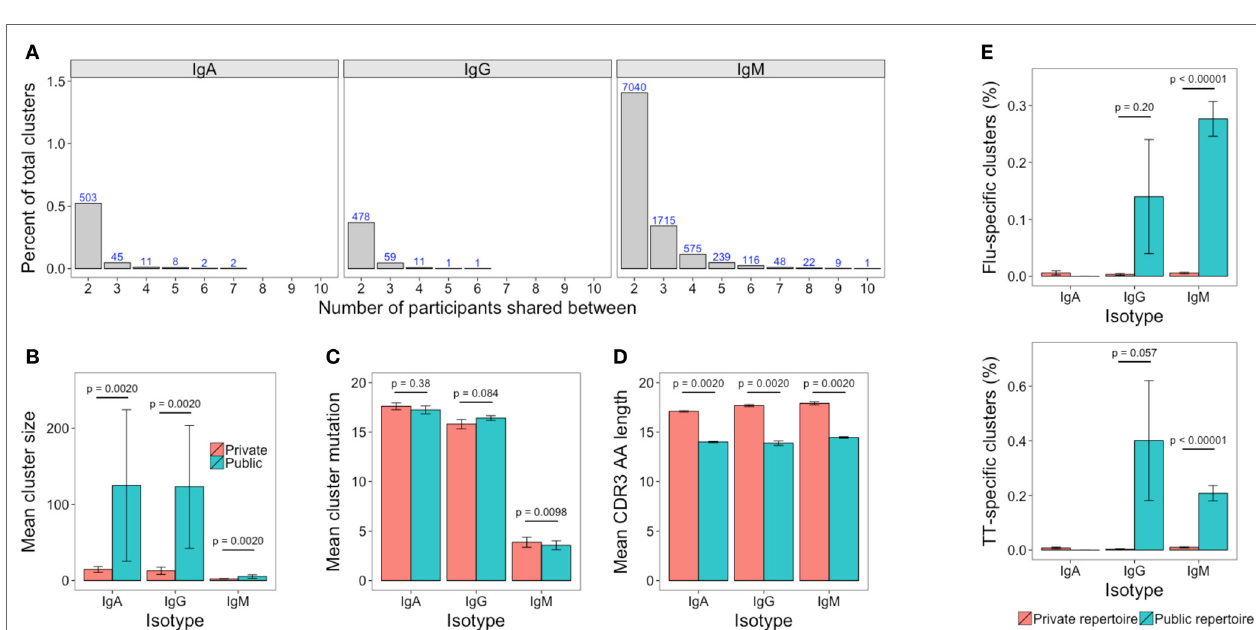
FigUre 6 | inter-individual variation in global repertoire properties . (a) Principal component analysis of VJ segment usage in each participant. Five samples from participant AF01 are included, each corresponding to a sample from a different day. Differences in mean number of V gene mutations of sequences in the repertoire (B) , repertoire diversity (calculated using the Shannon diversity index) (c) , and proportion of the repertoire comprised by sequences of each IgG and IgA subclass (D) in each participant. For (B–D) , bars show mean values ± SEM.